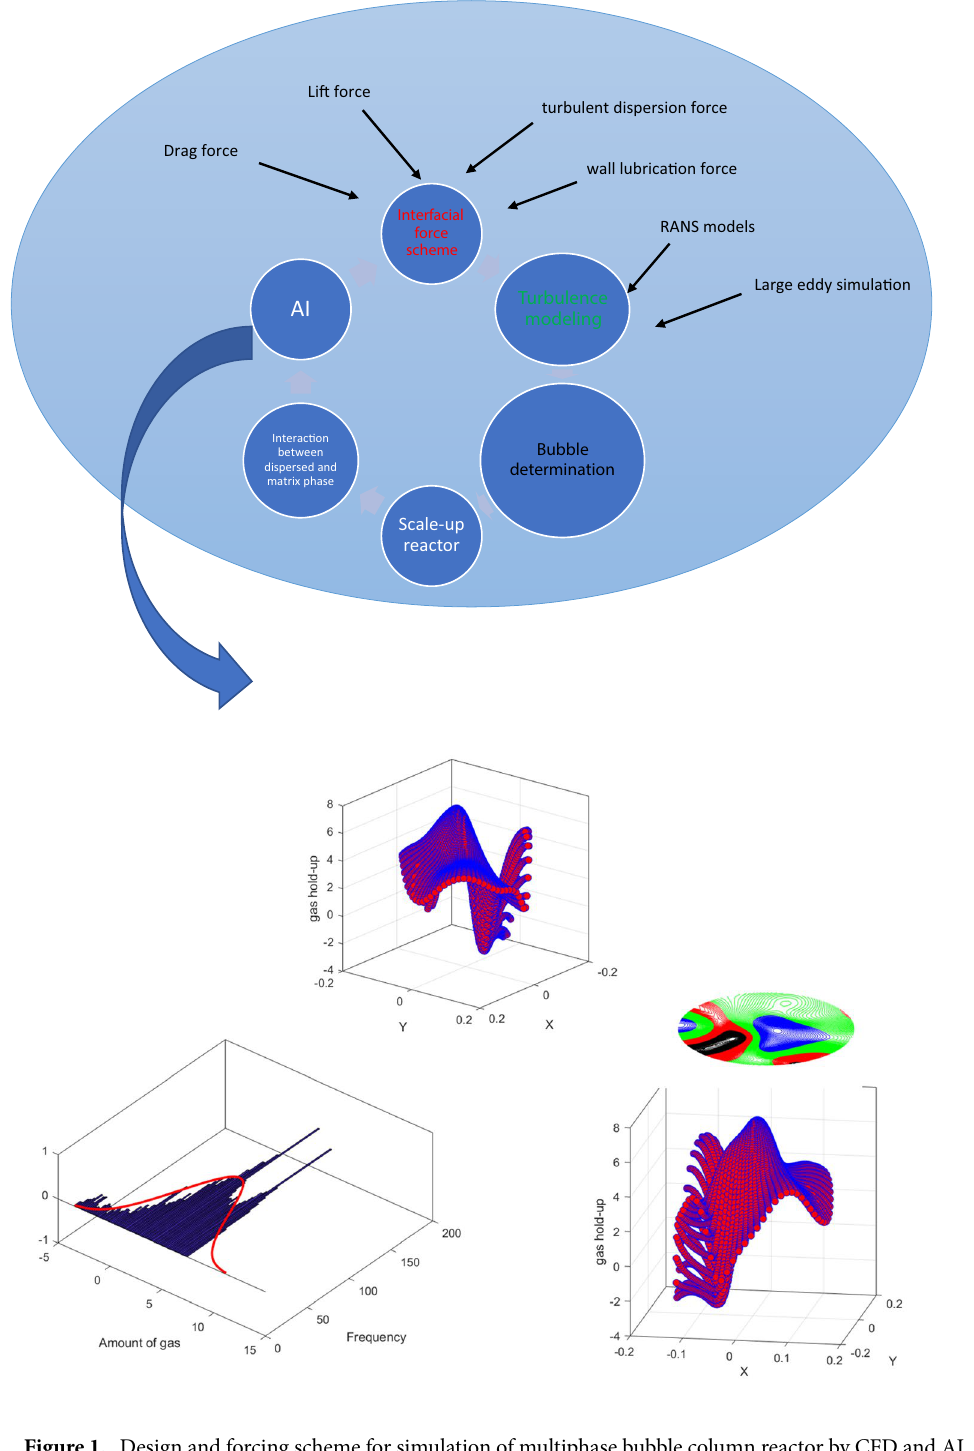
Figure 1. Design and forcing scheme for simulation of multiphase bubble column reactor by CFD and